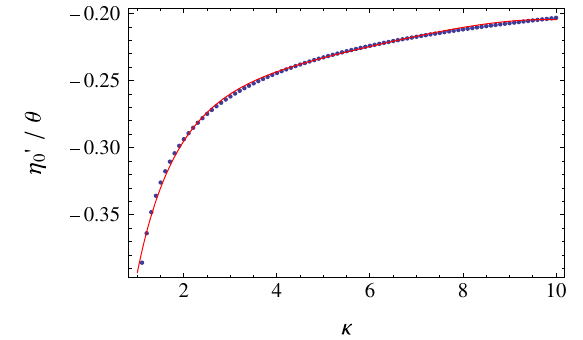
=(cid:4) for minimum EME 0